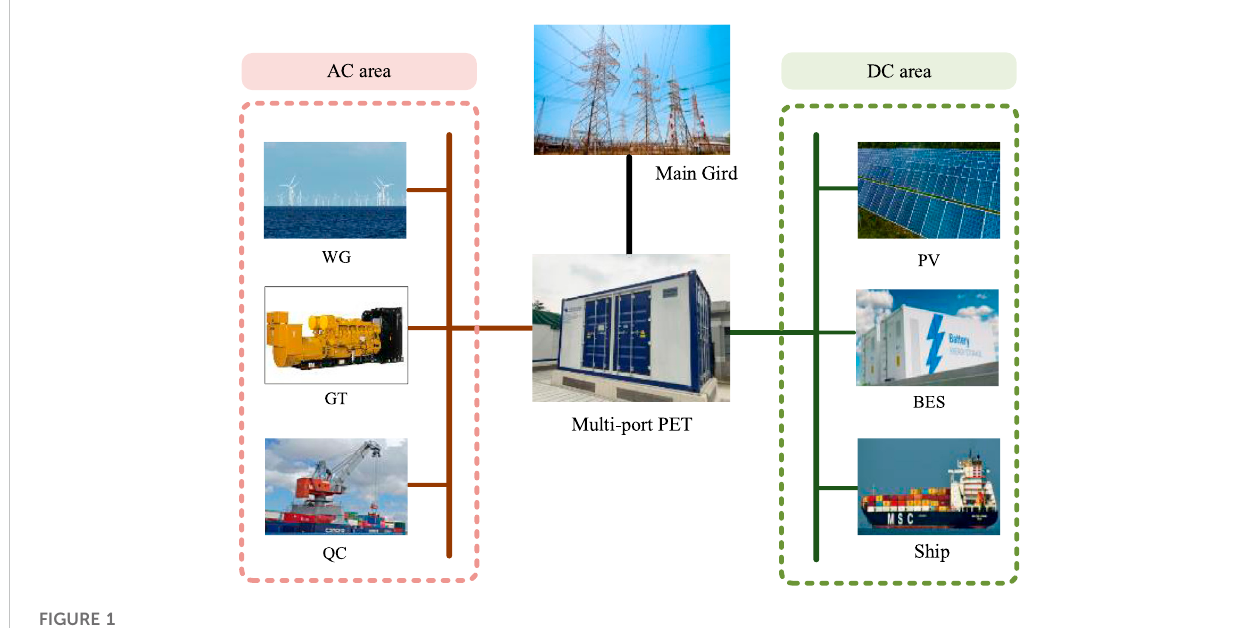
FIGURE 1 Structure of the green port with the multiport PET